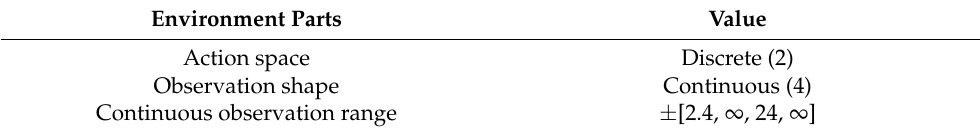
Table 1. Environment of the cart-pole balancing problem.